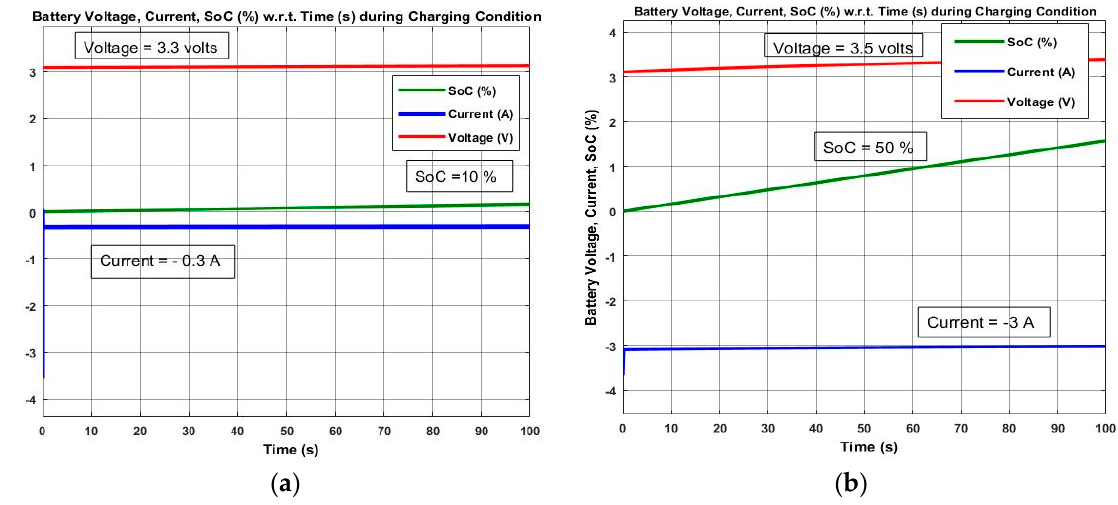
Figure 11. Simulation results of PWM controlled and P&O MPPT controlled solar SEH system for 100 s. ( a ) Battery SoC, Voltage and Current during Charging using PWM control; ( b ) Battery SoC, Voltage and Current during Charging using P&O MPPT control.